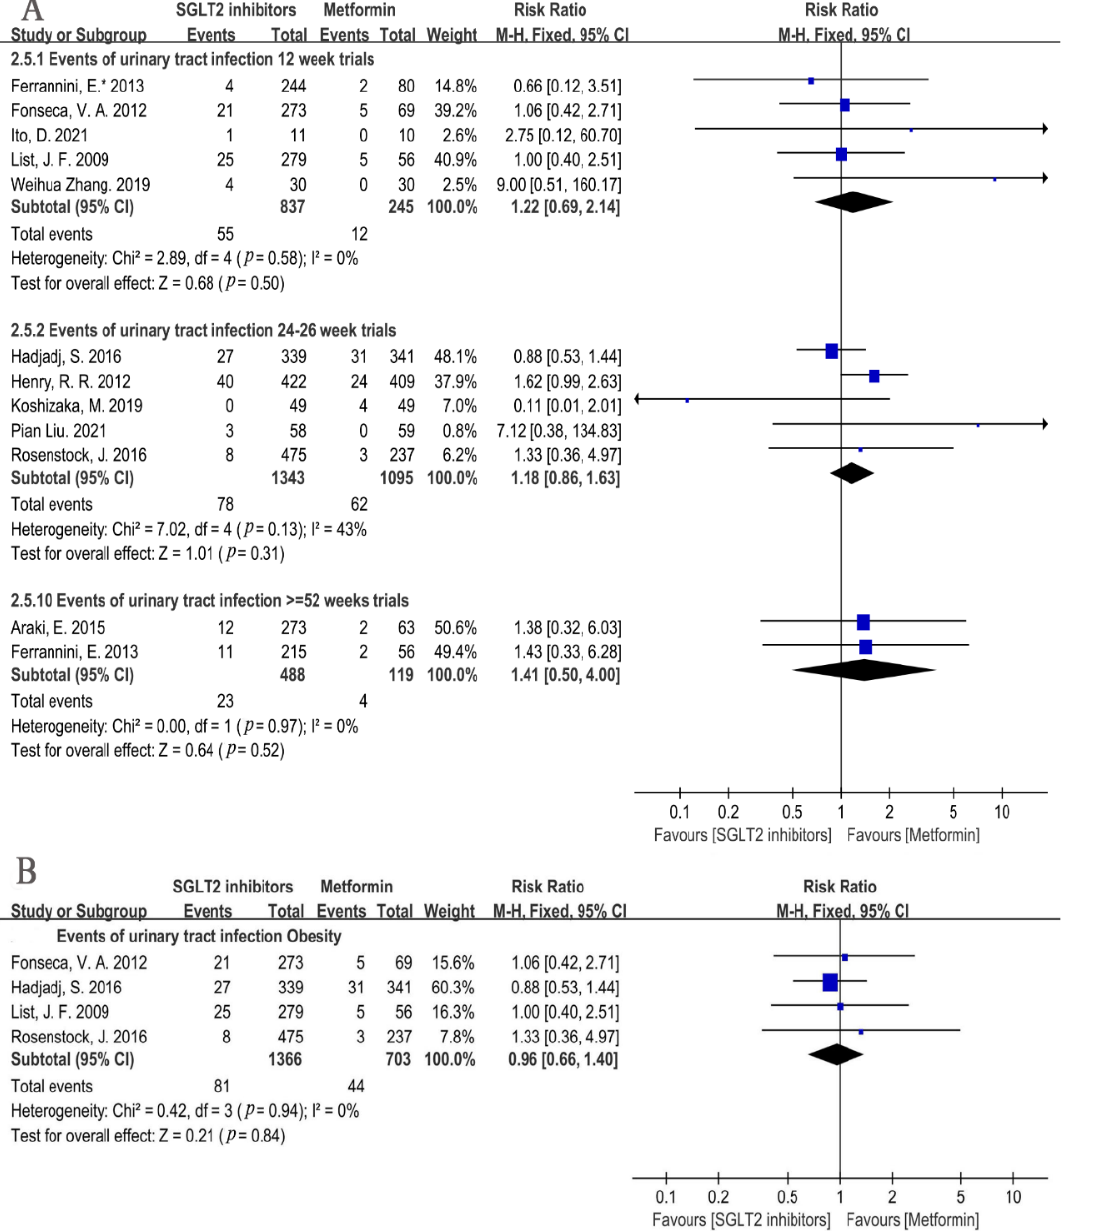
Figure 8. ( A ) Risk of urinary tract infections in patients with different treatment times of SGLT2i at 12 weeks, 24–26 weeks, and ≥ 52 weeks compared with that of metformin [20–29,31,32]. ( B ). Risk of urinary tract infections with SGLT2i compared with of metformin in obesity patients [22,25,29,31]. Obesity = SGLT2i used in obese people.